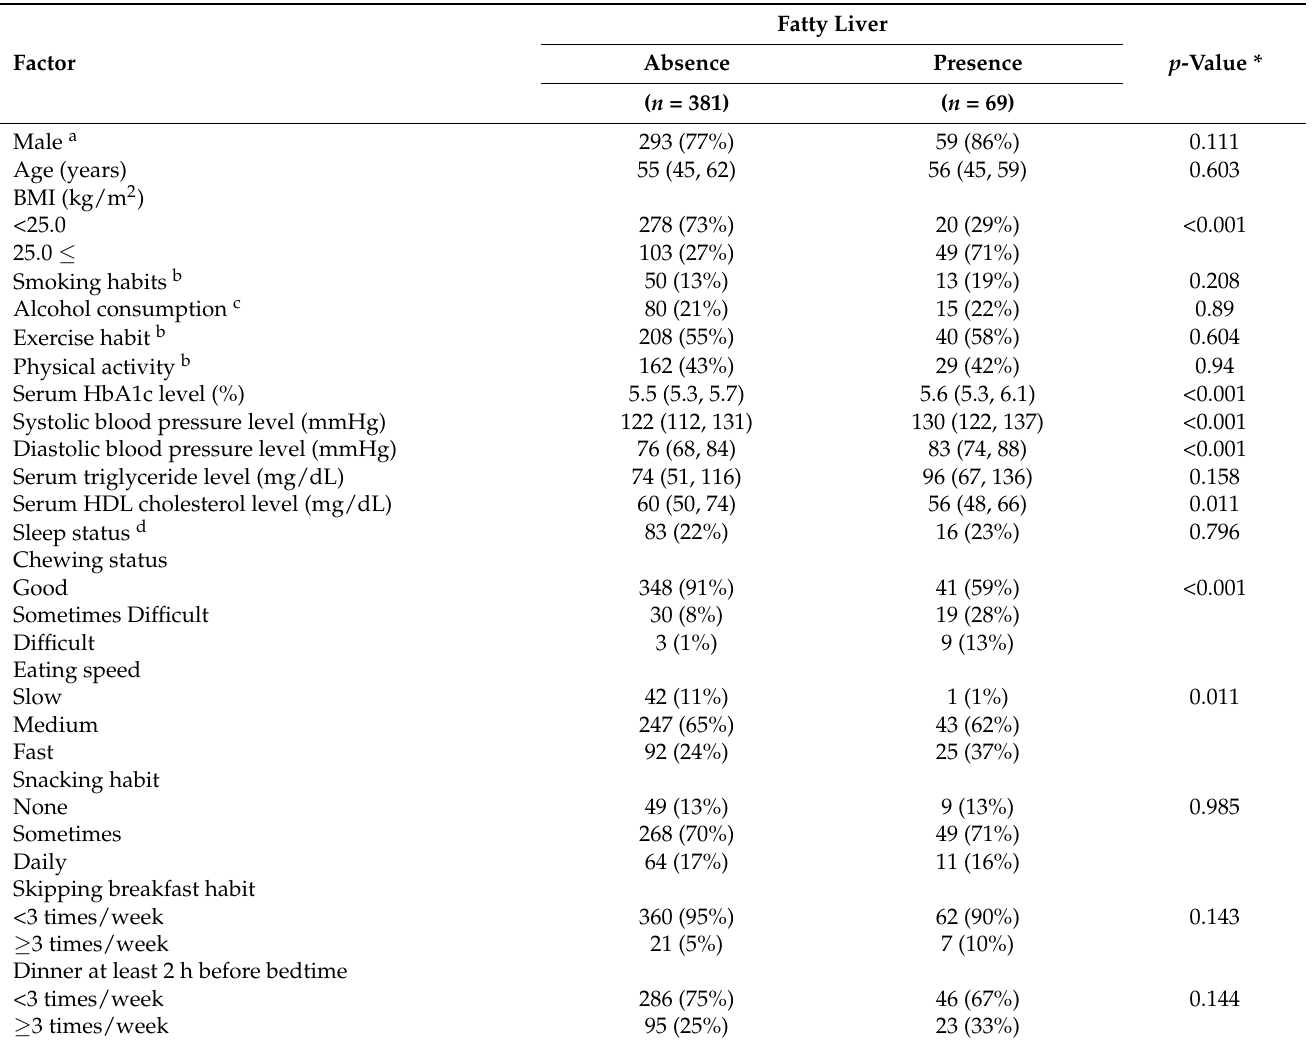
Table 1. Participant characteristics according to absence or presence of fatty